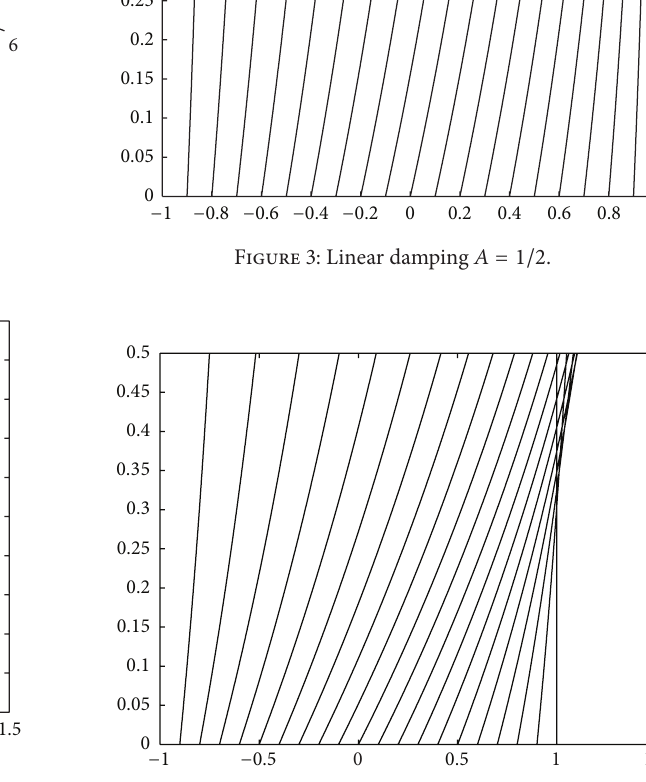
Figure 4: Linear damping 𝐴 = 2